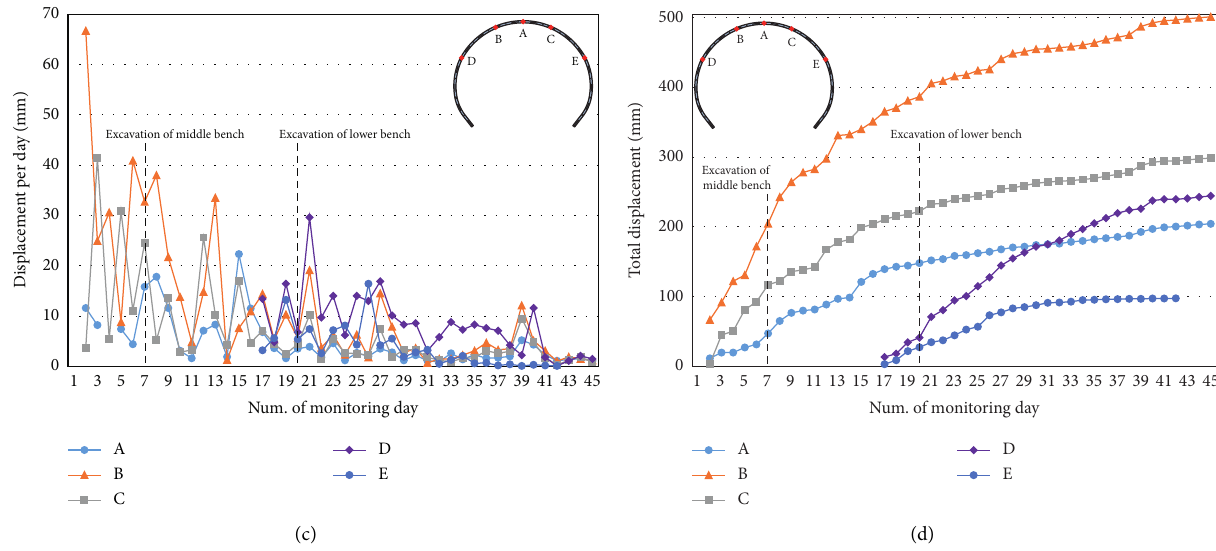
Figure 10: Time-history curve of the deformation of the primary lining: (a) diurnal and (b) accumulative displacement at Z5K64+500; (c) diurnal and (d) accumulative displacement at